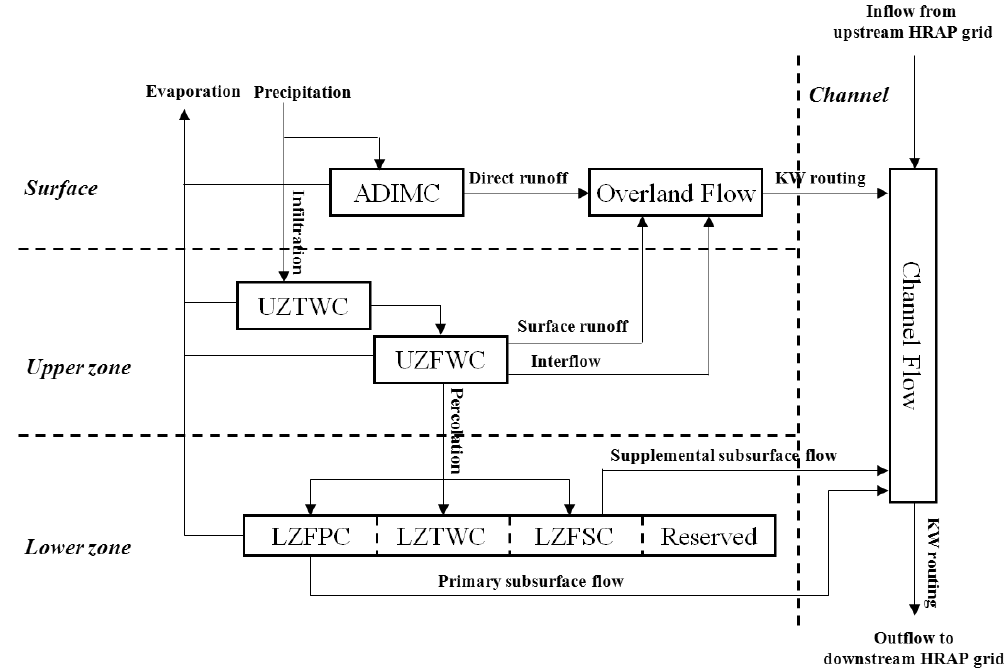
Fig. 1. Schematic of the gridded SAC and kinematic-wave routing models of HL-RDHM (from Lee et al., 801